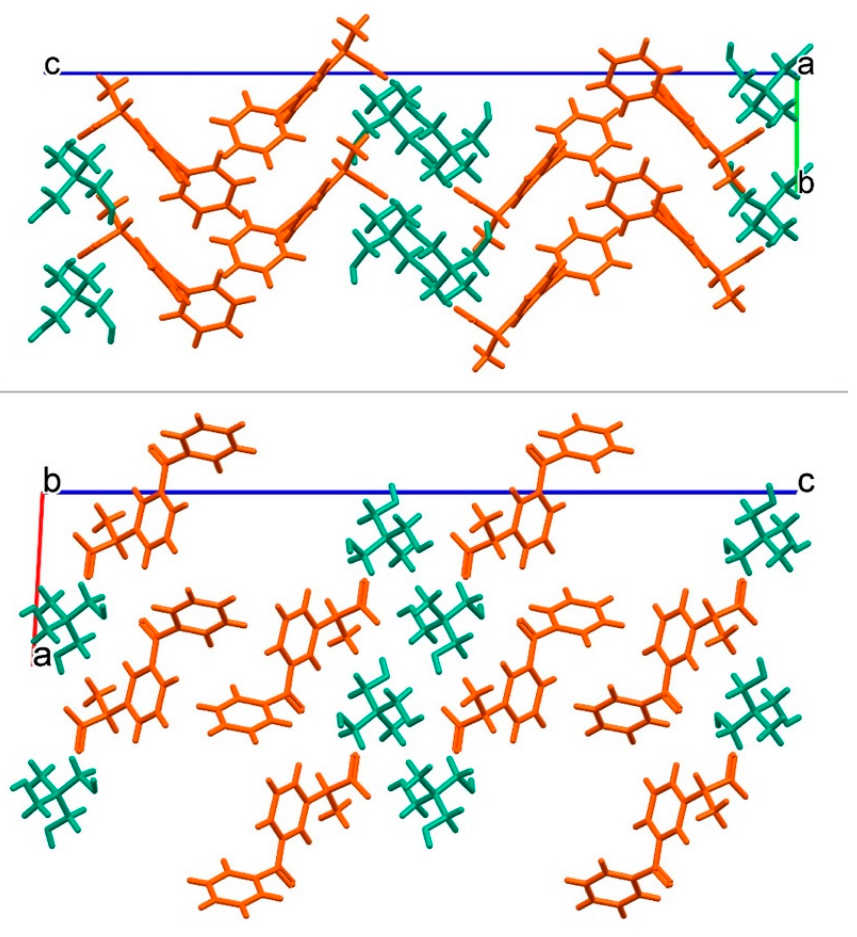
Figure 7. Crystal packing in a 2 × 2 × 1 structure viewed along the a -axis ( top ) and b -axis ( bottom ). Ketoprofen and tromethamine are coloured in orange and emerald green, respectively.